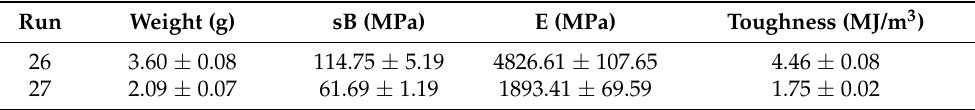
Table 9. Average and standard deviations values of measured responses for weight, flexural strength, flexural modulus of elasticity, and flexural toughness, for the confirmation